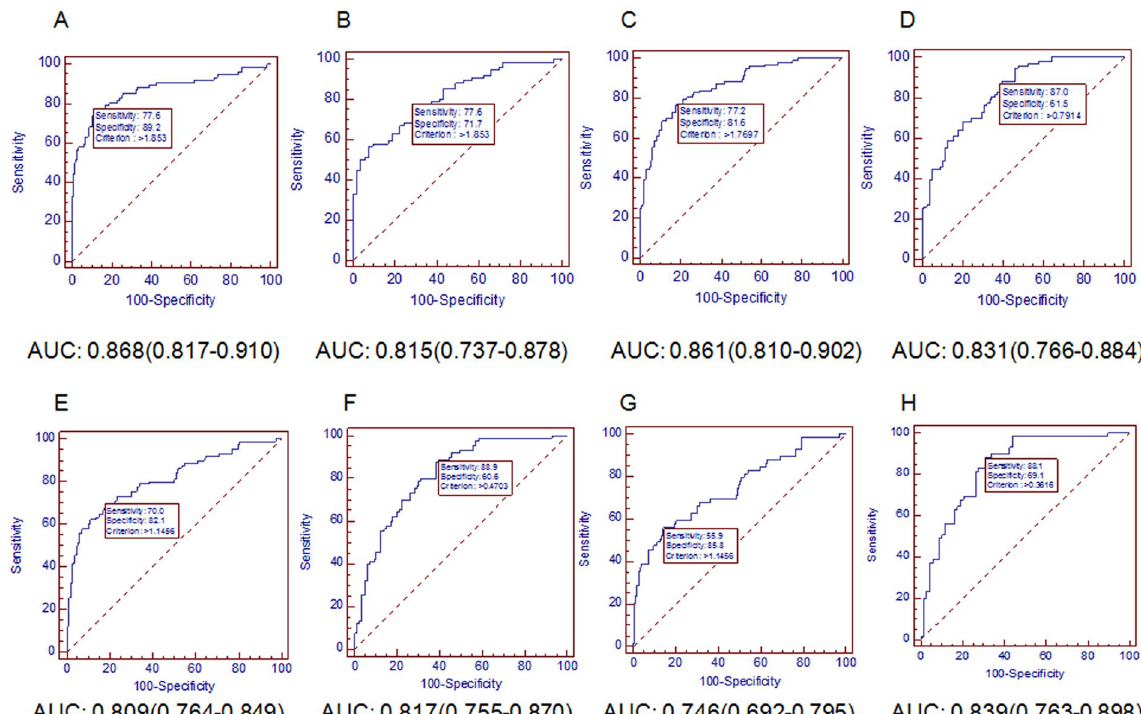
Figure 3. ROC analysis of APAR for HCC diagnosis. AUC of APAR for predicting HCC in ( A ) HCC versus non-cancer control in the training set, ( B ) HCC versus CHB in the training set, ( C ) HCC versus non-cancer control in the validation set, ( D ) HCC versus CHB in the validation set, ( E ) HCC versus non-cancer control in the whole set of participants of low or normal AFP ( < 100 ng/mL), ( F ) HCC versus CHB in the whole set of participants of low or normal AFP ( < 100 ng/mL), ( G ) HCC versus non-cancer control in the whole set of participants of normal AFP ( < 20 ng/mL), ( H ) HCC versus CHB in the whole set of participants of normal AFP ( < 20 ng/mL).